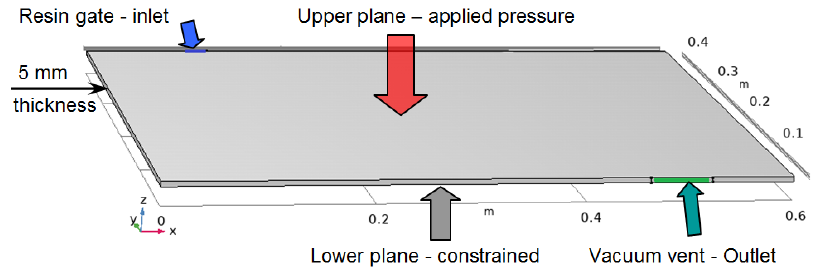
Figure 2. Geometry of the modeled system.